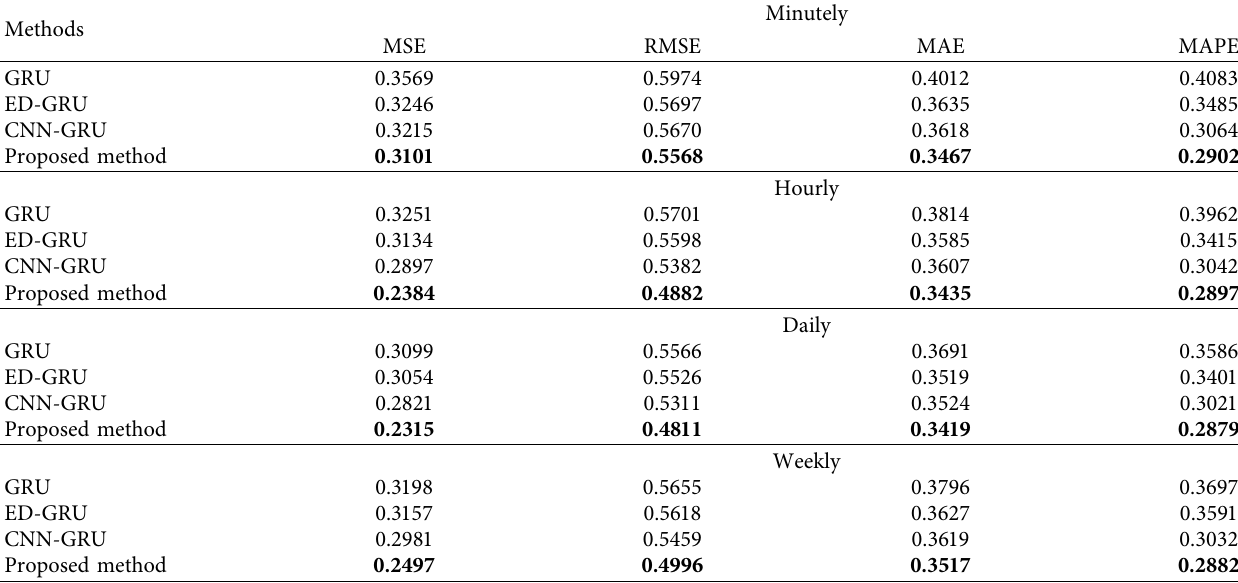
Figure 4: Data representation of the publicly available household power dataset [43] with different horizons. (a) Minutely data. (b) Hourly data. (c) Daily data. (d) Weekly data. Table 3: Performance results of the proposed method and its comparison with other competitive deep learning models on the household power dataset for all time horizons such as minute, hour, daily, and